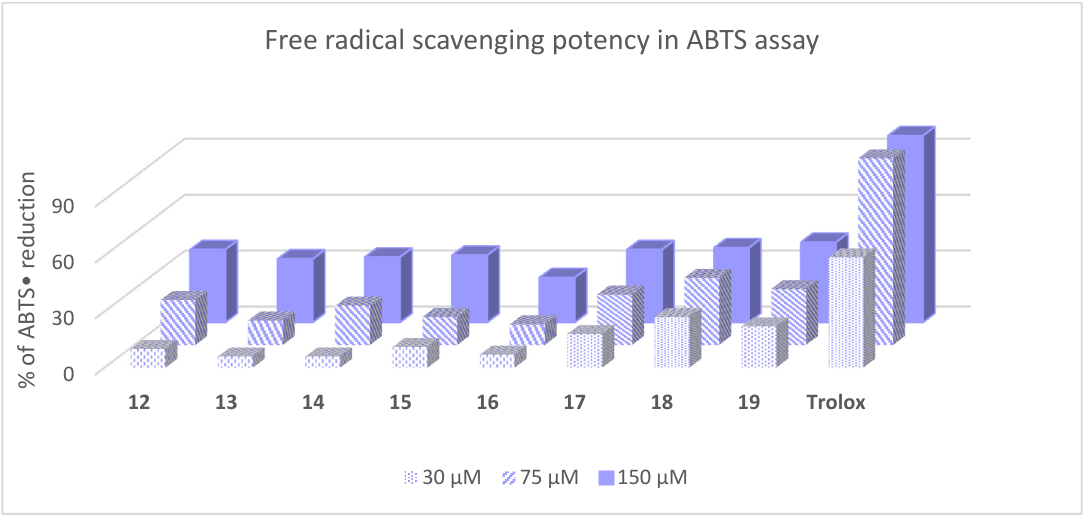
Figure 4. Results of ABTS assay: free radical scavenging potency of the tested compounds 12 – 19 and